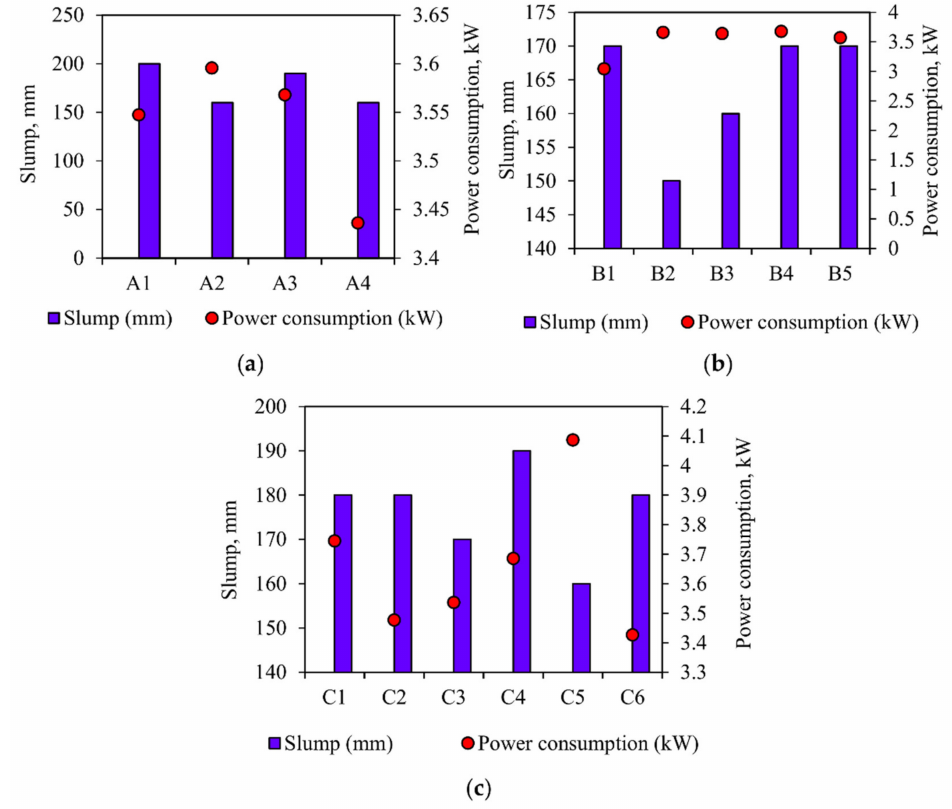
Figure 10. Power consumption versus slump value for ( a ) M25 grade concrete, ( b ) M30 grade concrete, ( c ) M40 grade